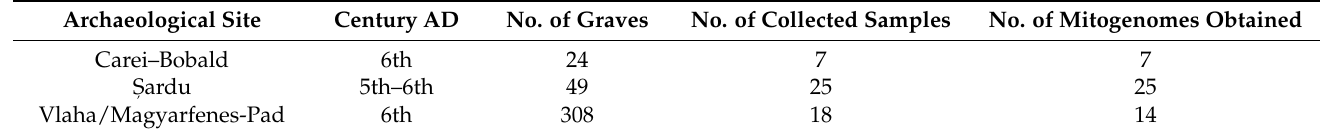
Table 1. Summary of the studied sample size from each